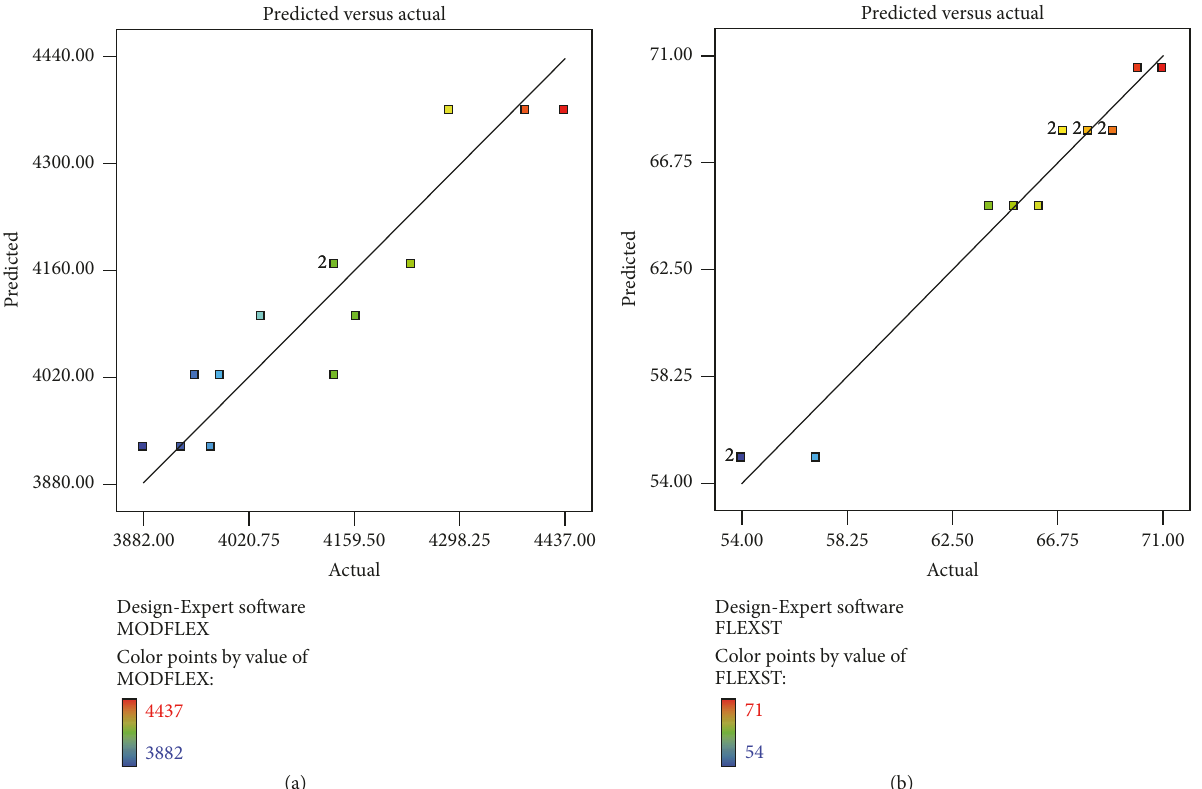
Figure 6: Predicted versus experimental data for flexural mechanical